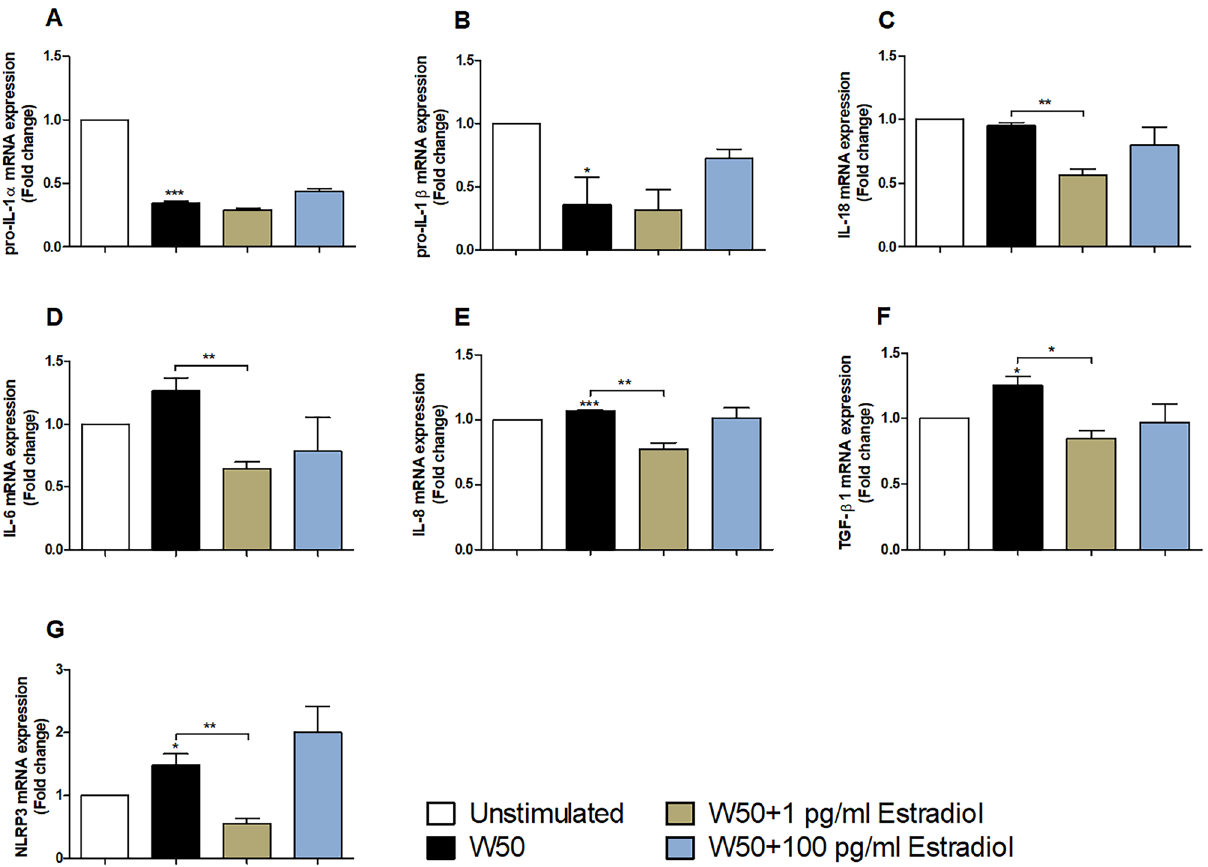
Figure 5. Estradiol alters P. gingivalis induced cytokine expression. Real-time qPCR analysis of pro-IL-1α ( A ), pro-IL-1β ( B ), IL-18 ( C ), IL-6 ( D ), IL-8 ( E ), TGFβ-1 ( F ) and NLRP3 ( G ) gene expression in gingival epithelial cells infected with P. gingivalis with or without estradiol (1 and 100 pg/ml) pre-treatment, after 24 h. Data are presented as mean ± SEM of n = 3 independent experiments. The asterisk distinguishes statistical significance: